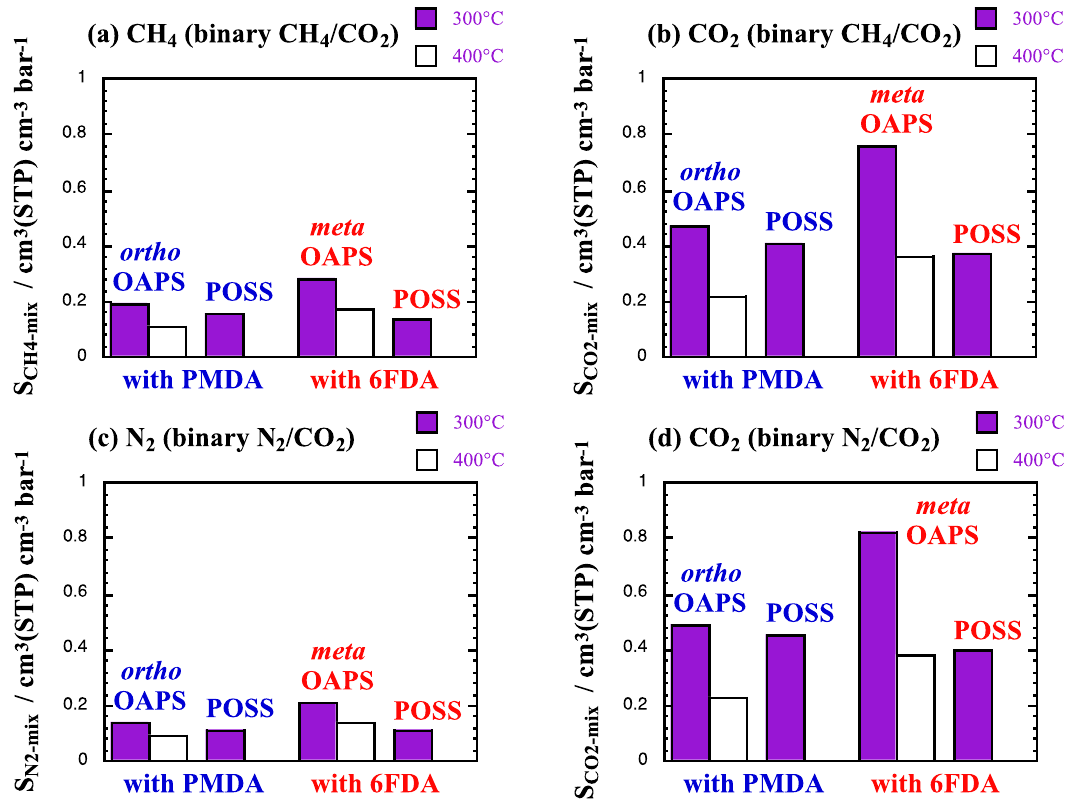
Figure 10. Mixed-gas solubility coefficients S gas-mix at 300 °C (purple bars) and 400 °C (white bars) in the selected polyOAPS/POSS-imides for ( a , b ) CH 4 and CO 2 from the 90%/10% CH 4 /CO 2 mixture and ( c , d ) N 2 and CO 2 from the 90%/10% N 2 /CO 2 mixture at 60 bar. The maximum standard error is 0.001 cm 3 (STP) cm − 3 bar − 1 .